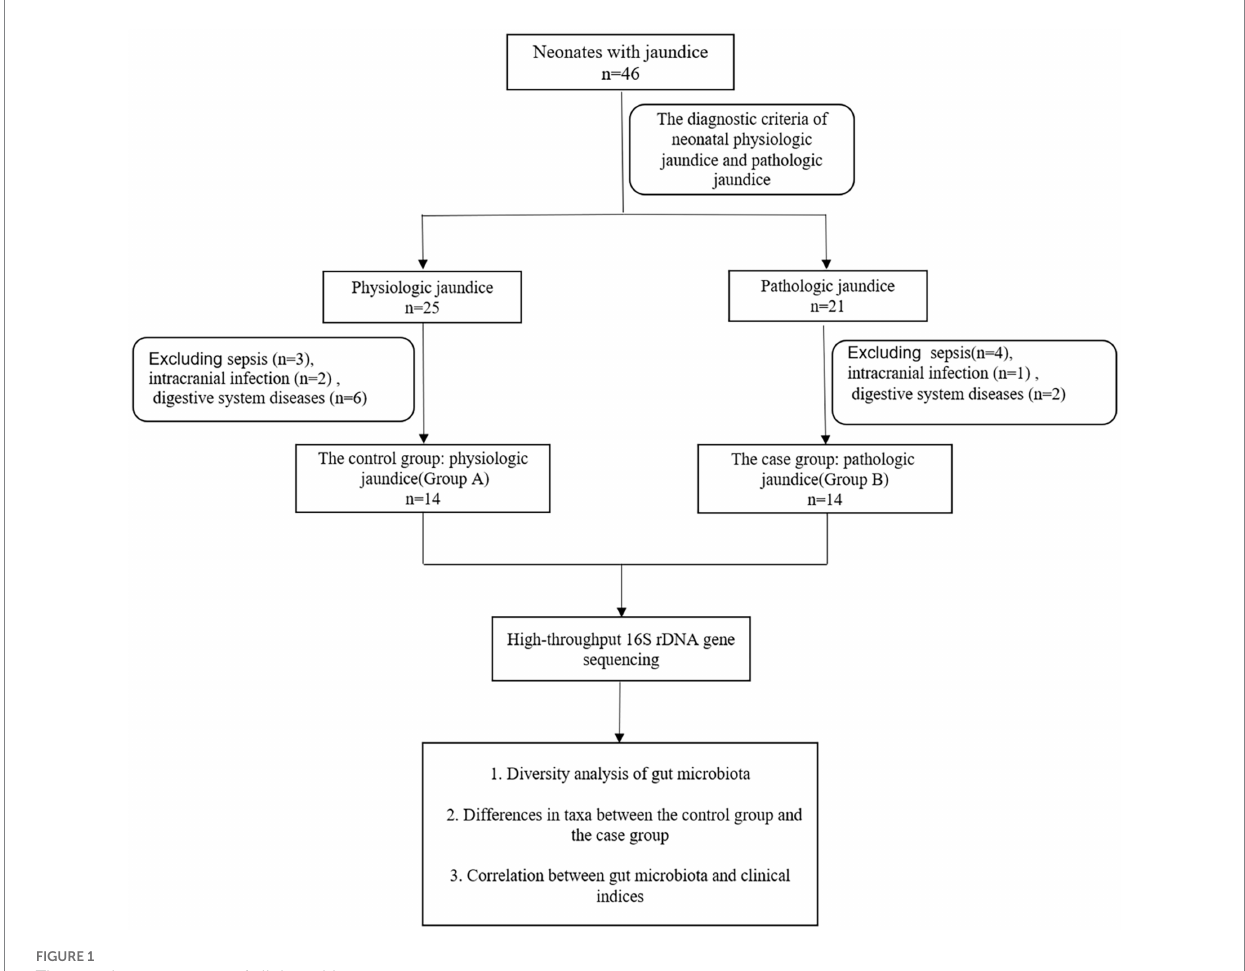
FIGURE 1 The recruitment process of all the